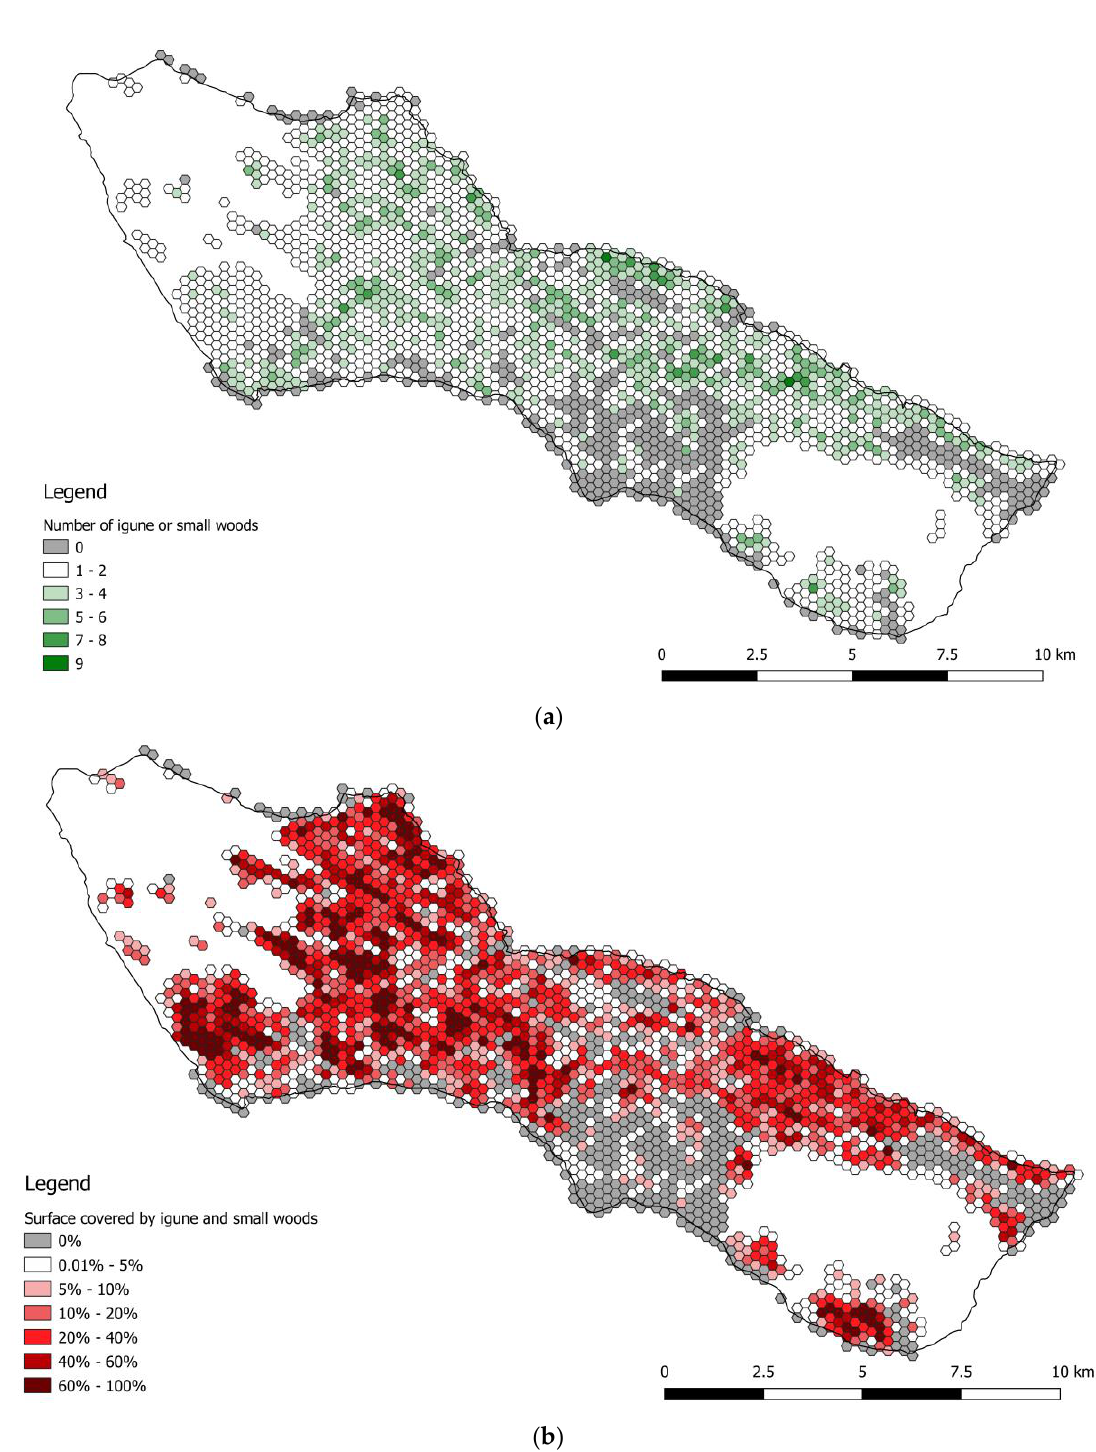
Figure 6. Maps of the number of patches of igune and other small woods per hexagon ( a ), and of the surface occupied by igune and other small woods per hexagon ( b ) for 2021. The situation for 2002 is almost identical. Table 4. Number of patches of igune and other small woods per hexagon and surface (in percent- age on the total hexagon surface) occupied by igune and other small woods per hexagon for 2002 and 2021. It is possible to notice that the situation is almost unchanged.